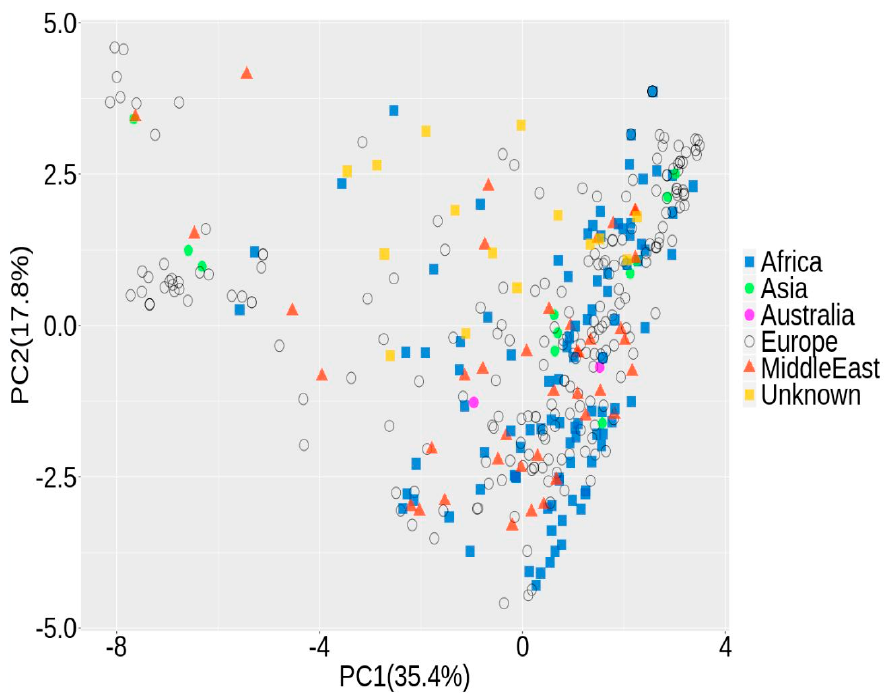
Figure 2. Scatterplot of accession distribution based on the first two principal components (PC1, PC2), labelled by origin.